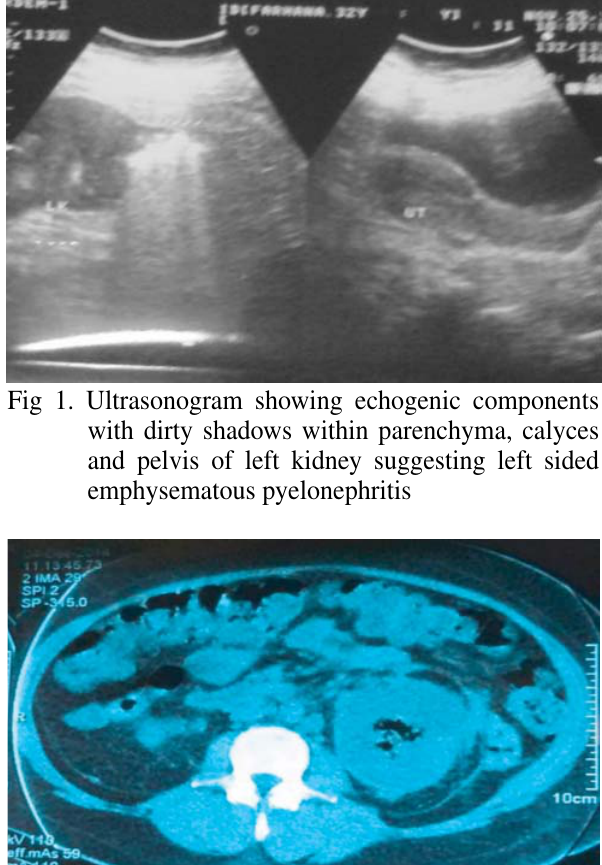
Table I: Abnormal laboratory findings of the patient with emphysematous